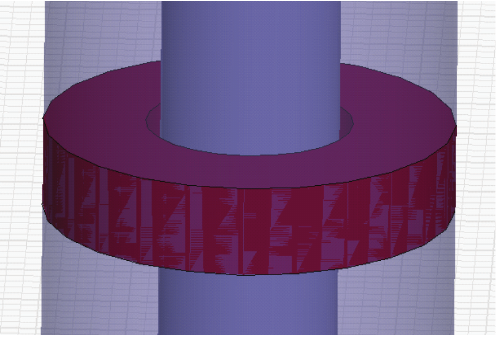
Figure 10: Modeling of sample air gap.